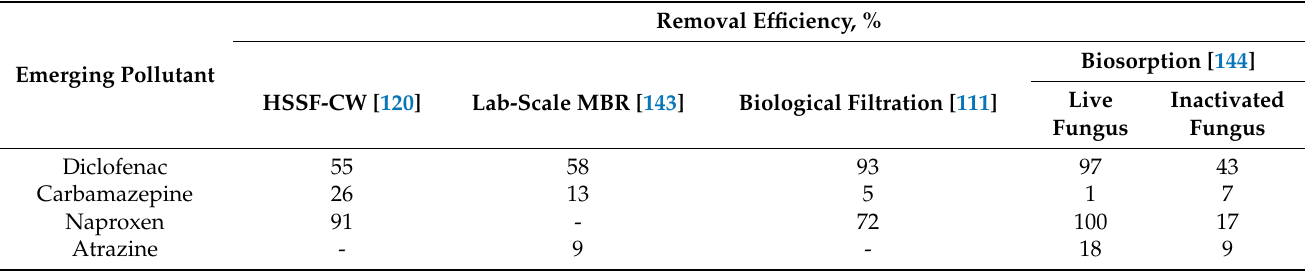
Table 9. Comparison of removal efficiency of some processes involving biological technologies for the removal of several emerging